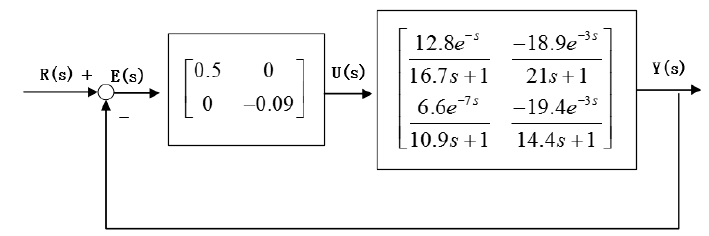
Figure 11. Wood-Berry system closed-loop control diagram.